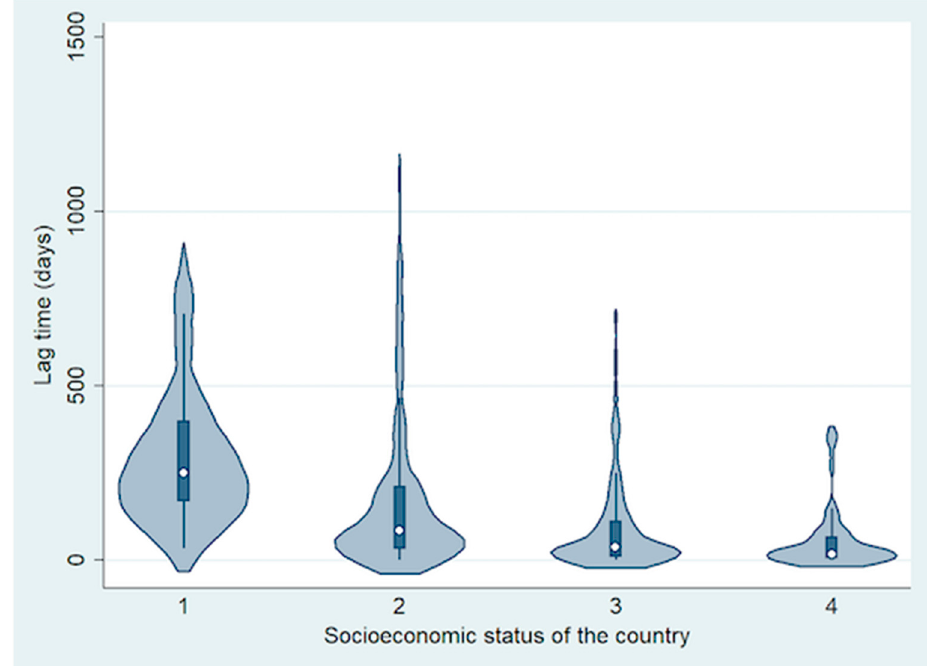
Figure 3. Violin plot showing the difference in lag time from first symptom to treatment based on socioeconomic status of the country.